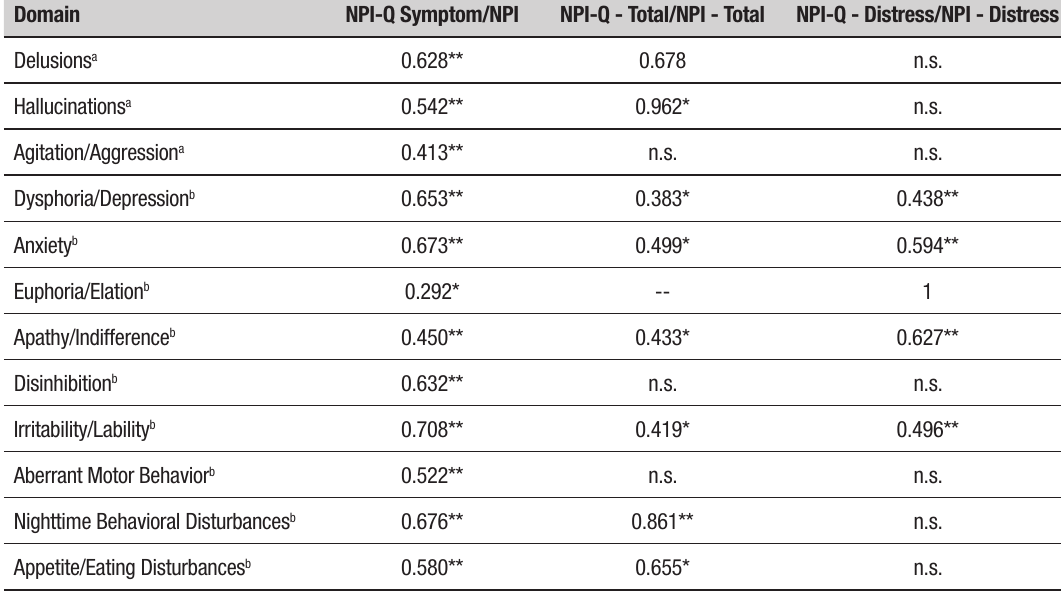
Table 3. Inter-scale correlations between the NPI and the NPI-Q.